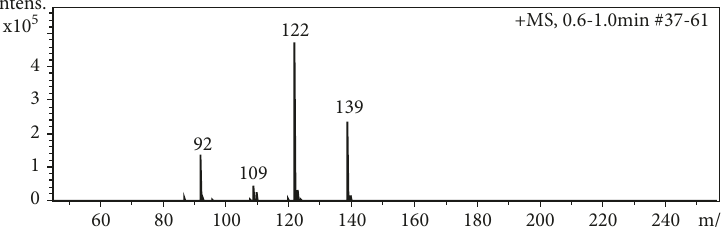
Figure 3: APCI mass spectrum of 10 𝜇 M 4-nitroaniline in methanol/H 2 O 1:1 ( v/v ). m/z 139 is the molecular ion ( M + H ) + .